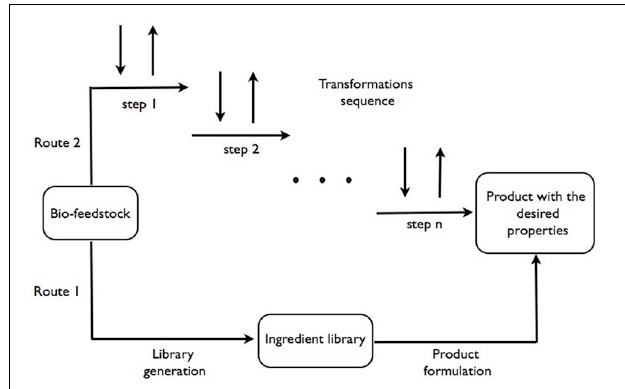
FIGURE 1 | Schematic representation of both current and proposed approaches to processing bio-feedstocks in product design.